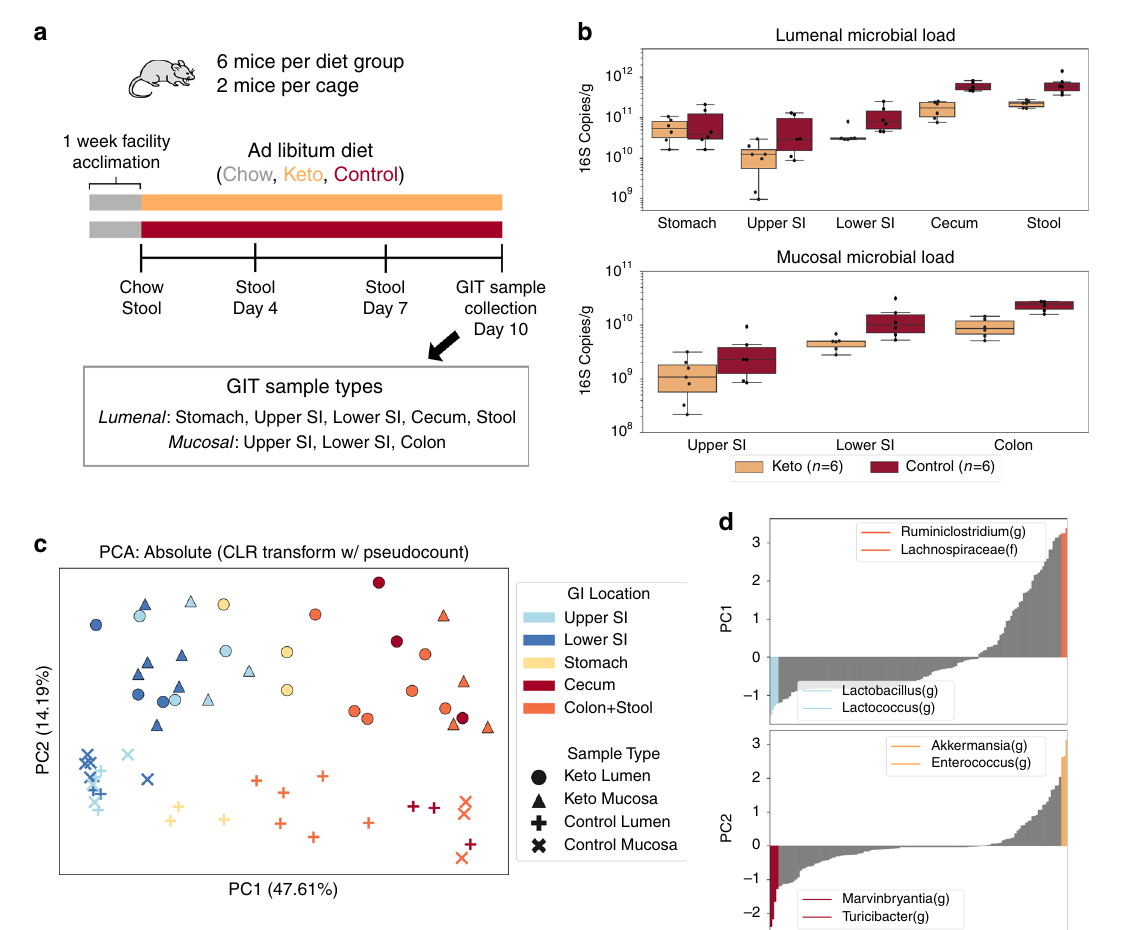
Fig. 4 Microbial absolute abundances provide separation between GI locations of mice on ketogenic or control diets. Analysis of data comparing ketogenic and control diets provides changes of total microbial loads, separation of microbial communities by GI location and by diet in principal component analysis, and the top taxa driving the separation of samples along the principal components. a Overview of experimental setup and sample- collection protocol. Gastrointestinal tract (GIT) samples were collected from the stomach, upper small-intestine (SI), lower SI, cecum, colon, and stool. b Comparison of total microbial loads between ketogenic and control diets in lumenal (top) and mucosal (bottom) samples collected after 10 days on each diet. The body of the box plot goes from the fi rst to third quartiles of the distribution and the center line is at the median. The whiskers extend from the quartiles to the minimum and maximum data point within 1.5× interquartile range, with outliers beyond. c Principal component analysis (PCA) on the centered log-ratio transformed absolute abundances of microbial taxa shows separation by GI location (Upper SI, light blue; Lower SI, dark blue; Stomach, yellow; Cecum, red; Colon + Stool, orange) and diet (Ketogenic, circles and triangles; Control, X ’ s and crosses). d Ranked order of the eigenvector coef fi cients scaled by the square-root of the corresponding eigenvalue (feature loadings) for the top two principal components. The two most positive and most negative taxa are